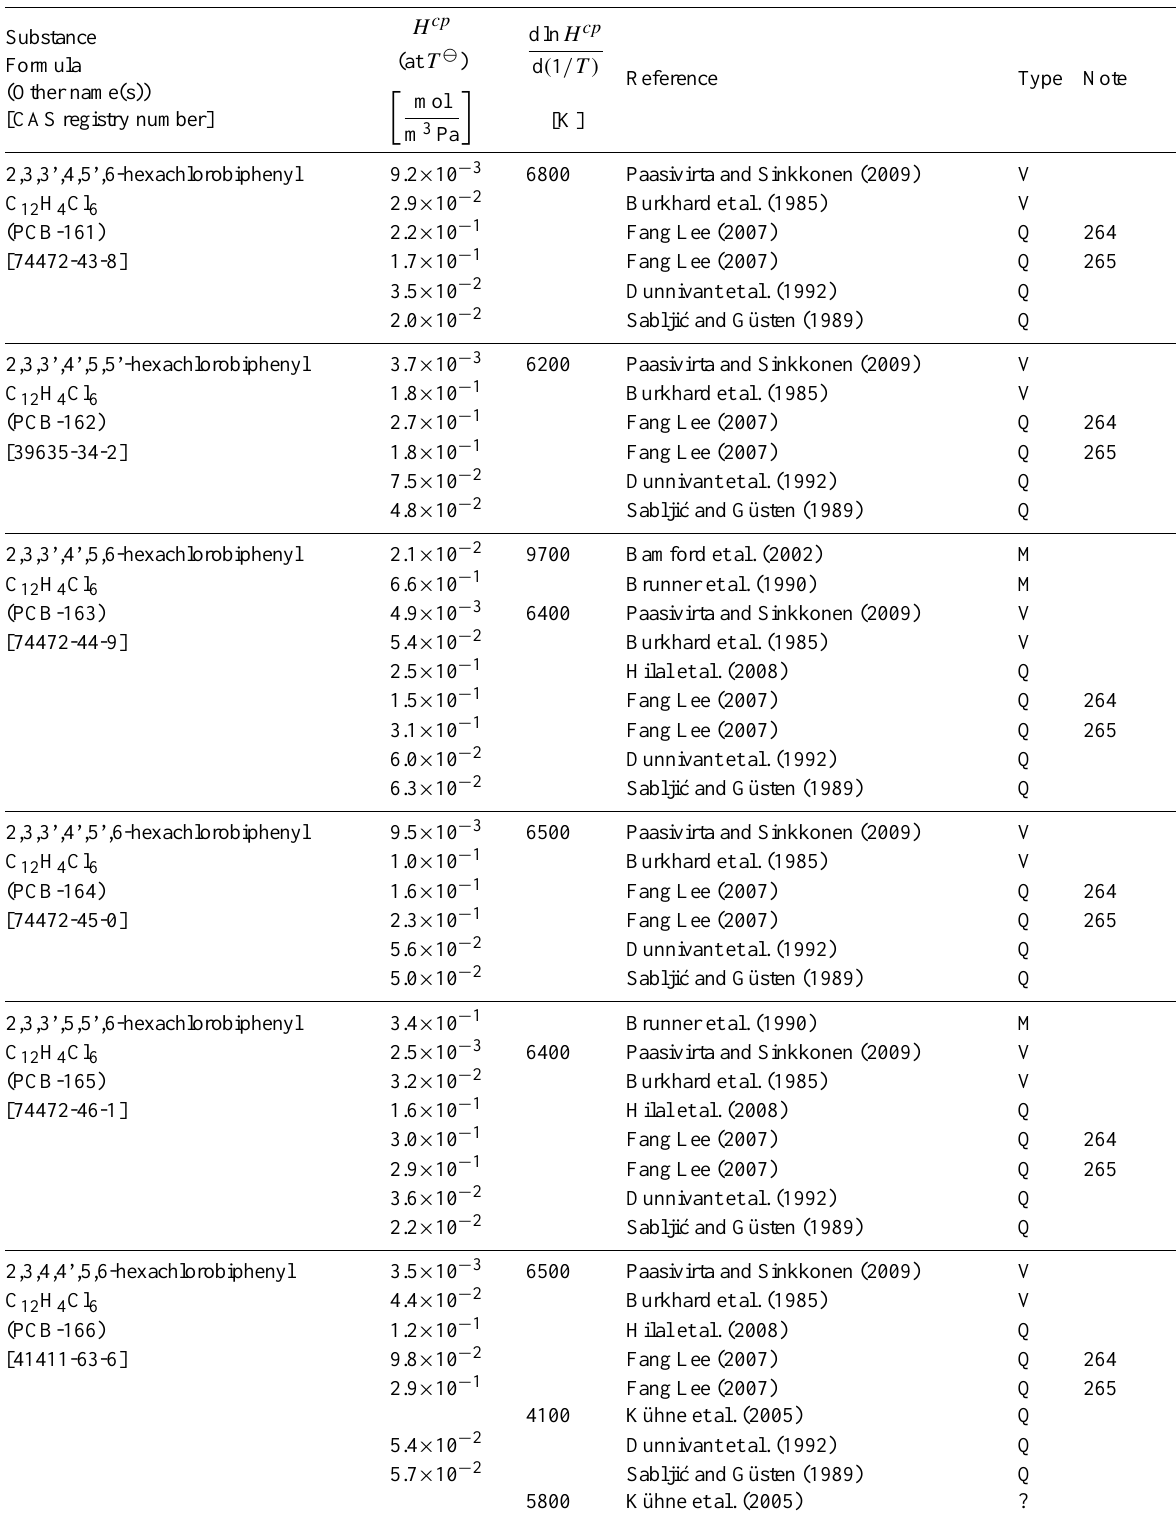
Table 6: Henry’s law constants for water as solvent